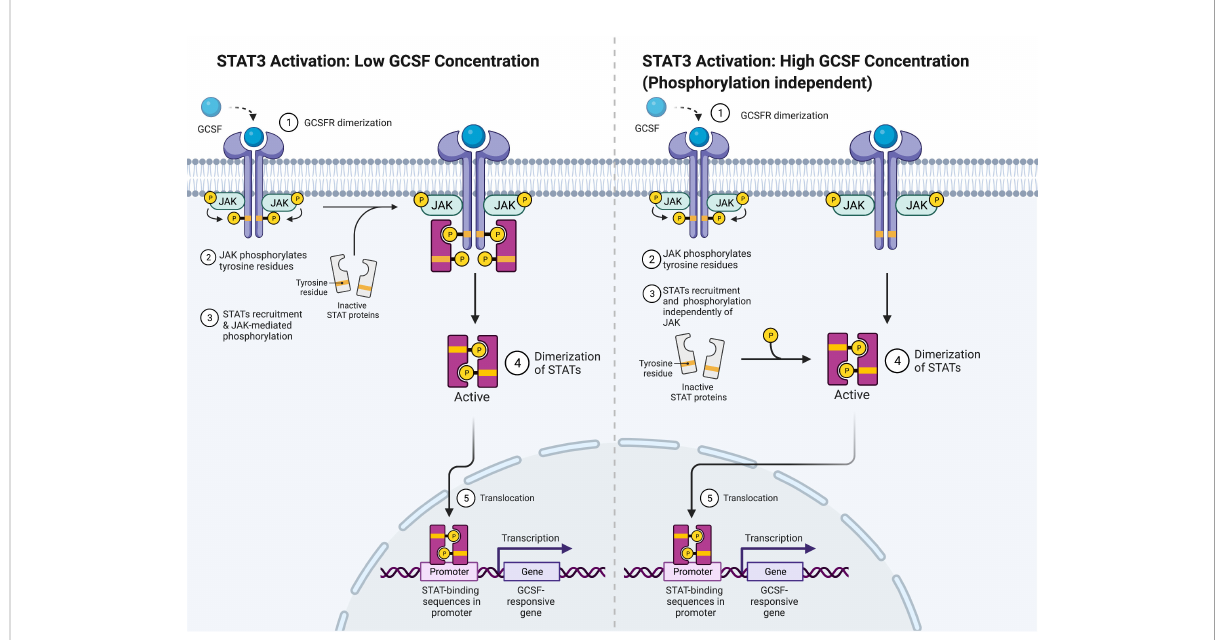
FIGURE 3 STAT3 Activation Mechanisms. Adapted from “ Cytokine Signaling through the JAK-STAT Pathway ” , by BioRender.com (2022). Retrieved from